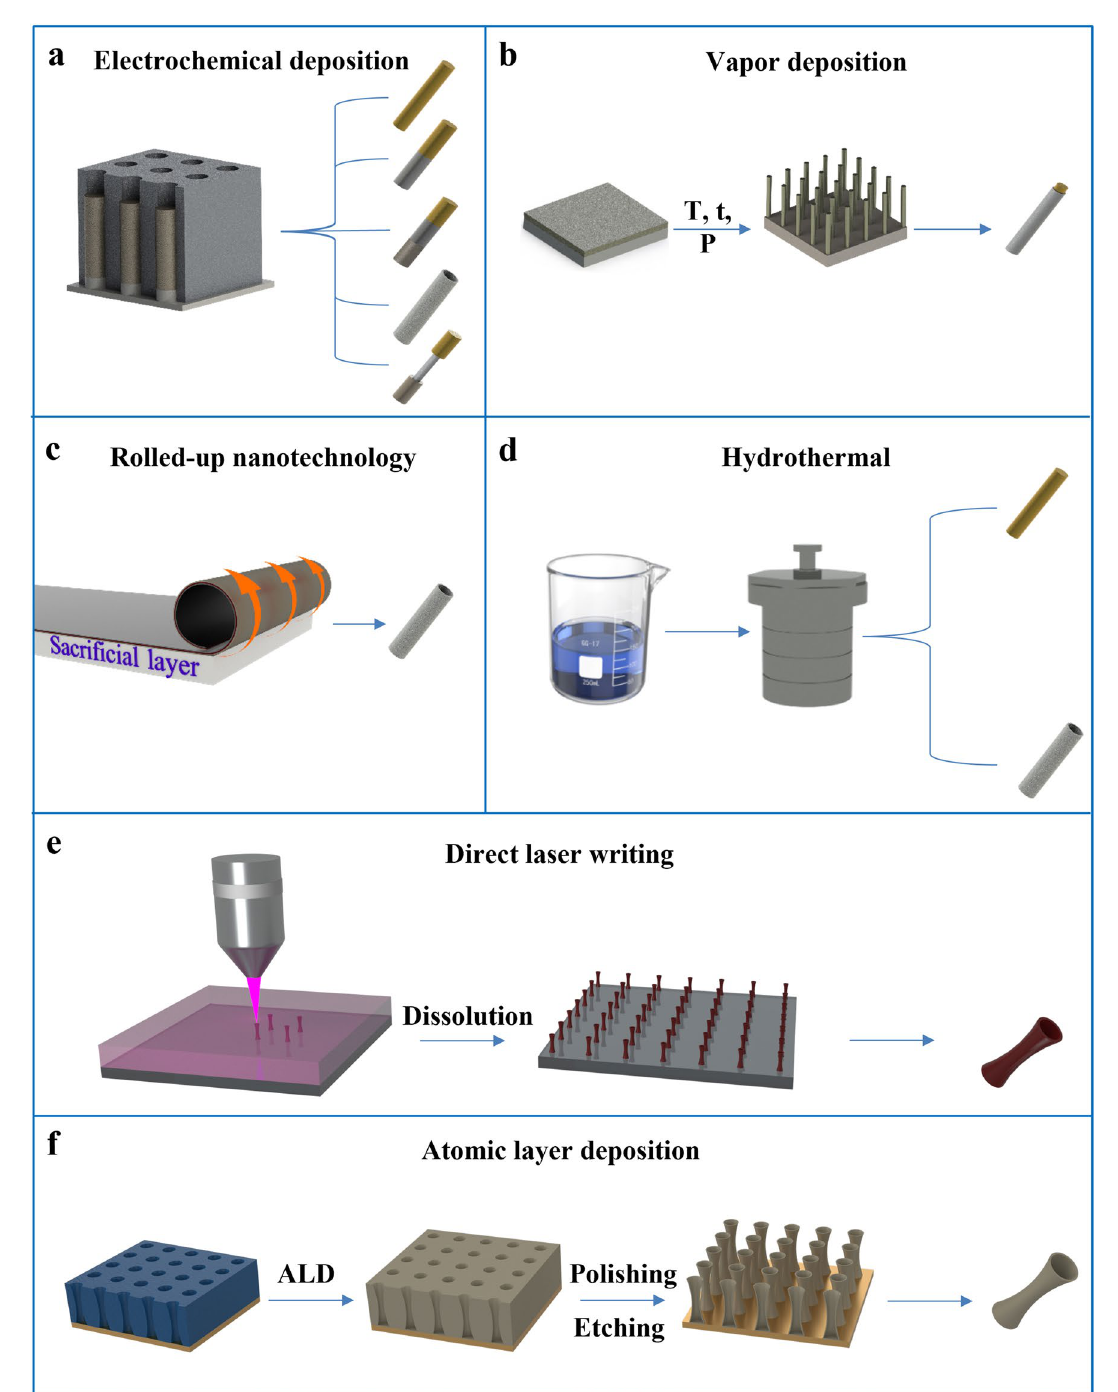
Fig. 2 Methods commonly used to prepare 1D micro/nanomotors. a Electrochemical deposition technique. b Vapor-phase deposition technique c Rolled-up nanotechnology. d Hydrothermal synthesis technique. e Direct laser writing. f Atomic layer